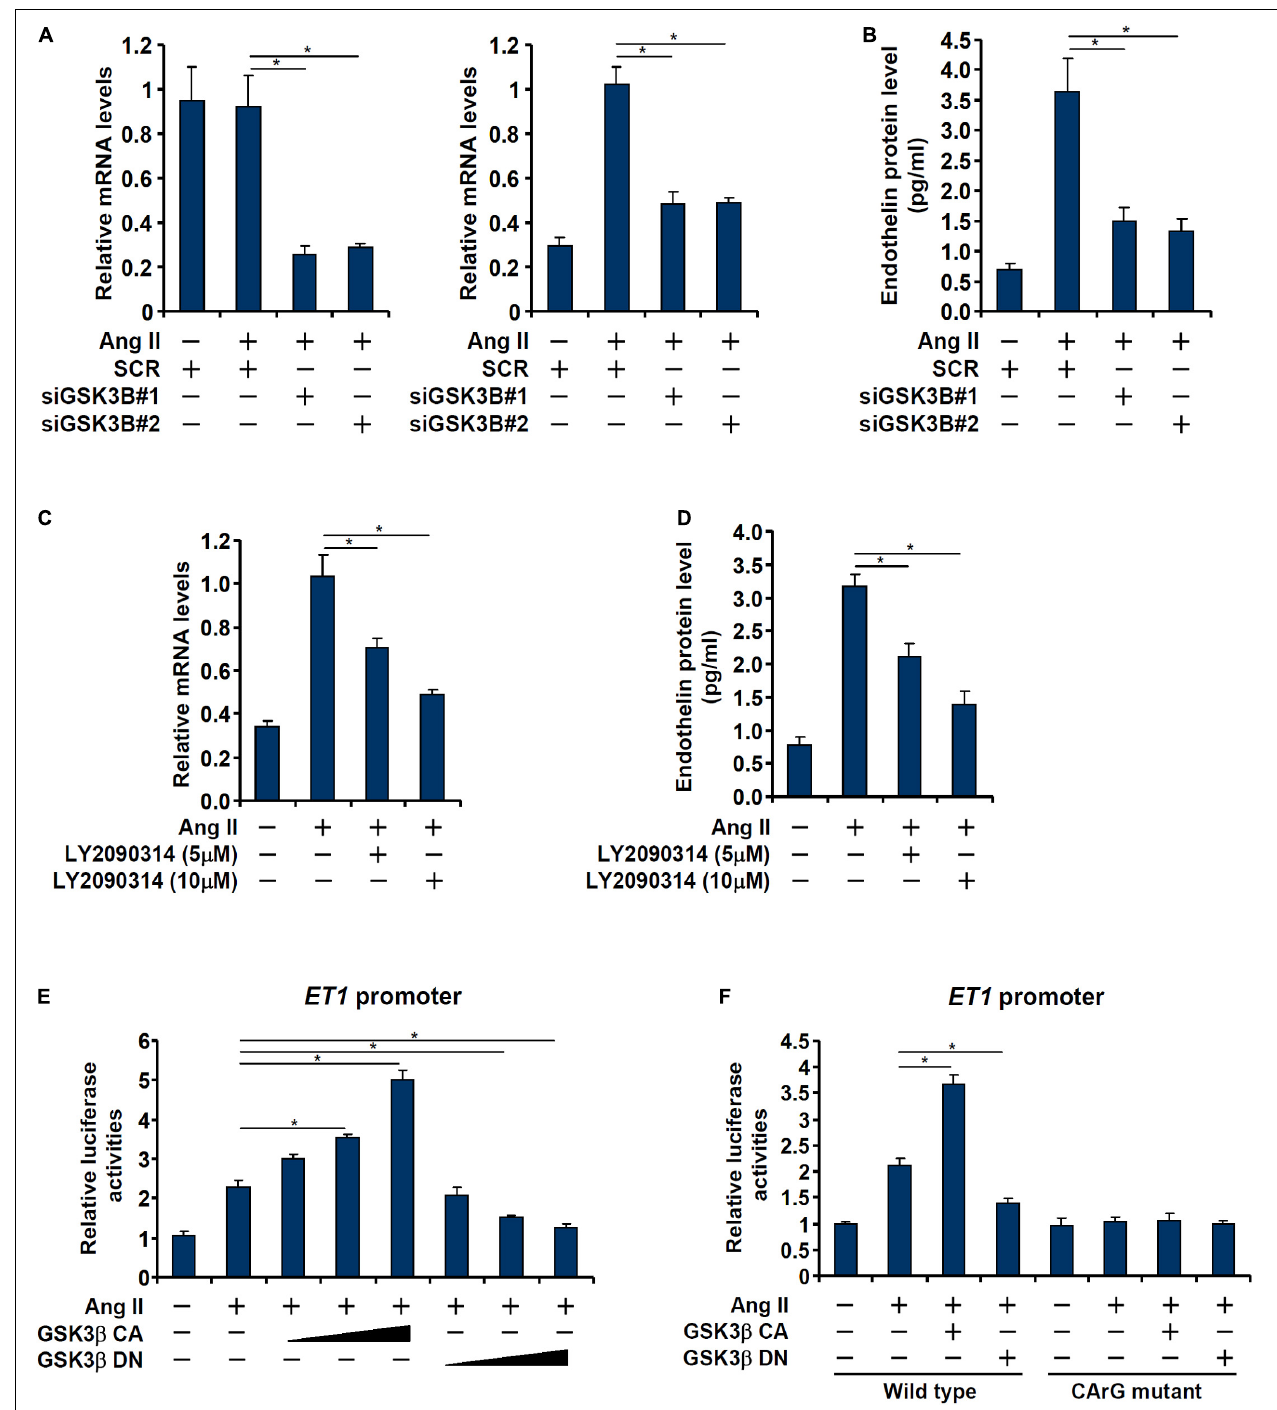
FIGURE 2 | GSK3 is essential for Ang II induced endothelin expression. (A,B) EAhy926 cells were transfected with siRNAs targeting GSK3 β or scrambled siRNA (SCR) followed by treatment with Ang II (0.1 µ M) for 48 h. Endothelin expression was examined by qPCR and ELISA. (C,D) EAhy926 cells were treated with Ang II (0.1 µ M) with or without LY2090314 for 48 h. Endothelin expression was examined by qPCR and ELISA. (E) An ET1 promoter-luciferase construct was transfected into EAhy926 cells with indicated GSK3 expression constructs followed by treatment with Ang II (0.1 µ M) for 48 h. Luciferase activities were normalized by protein concentration and GFP fluorescence. (F) Wild type or mutant ET1 promoter-luciferase construct was transfected into EAhy926 cells with indicated GSK3 expression constructs followed by treatment with Ang II (0.1 µ M) for 48 h. Luciferase activities were normalized by protein concentration and GFP fluorescence. Error bars represent SD (* p < 0.05, two-way Student’s t -test). All experiments were repeated three times and one representative experiment is shown.